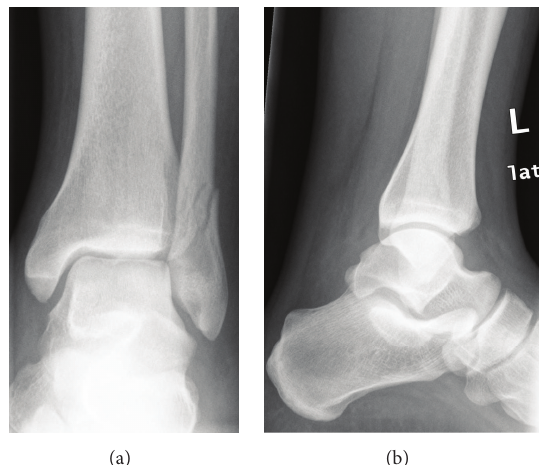
Figure 1: Plain (a) anteroposterior and (b) lateral radiographs of the left ankle on initial presentation revealing a nondisplaced, short, oblique fracture of the lateral malleolus, Danis-Weber B.